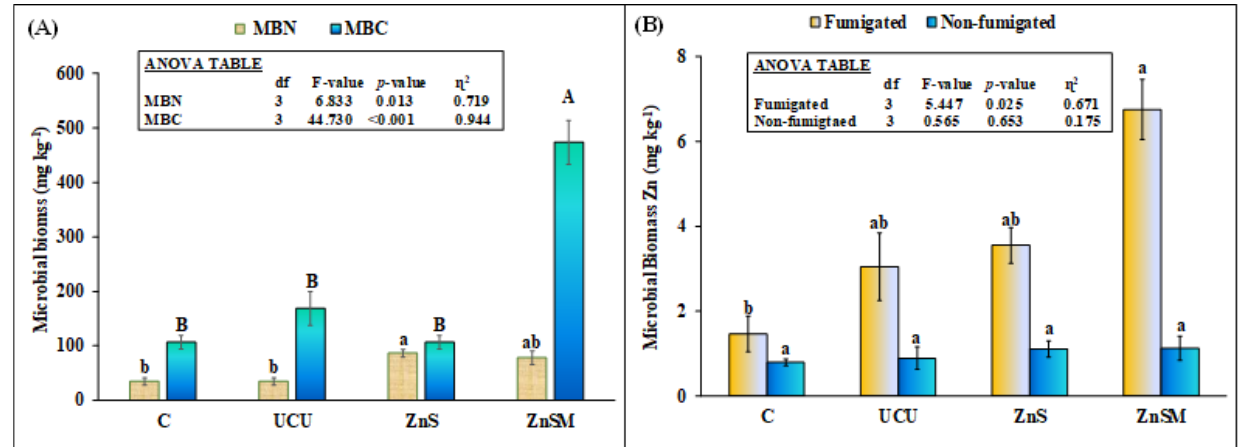
Figure 5. Mean ( n = 3) soil organic carbon (DOC) ( A ), mineral nitrogen ( B ), plant available phosphorous ( C ) and zinc ( D ) as affected by application of uncoated (UCU) and coated urea with zinc sulphate (ZnS) and zinc sulphate plus molasses (ZnSM). C represents untreated control. Error bars showed standard errors of the means. Different small letters represented significance differences among treatments at 5% probability level. Inset shows ANOVA Table. Multiple comparisons among treatments were analyzed by Tukey’s HSD test.